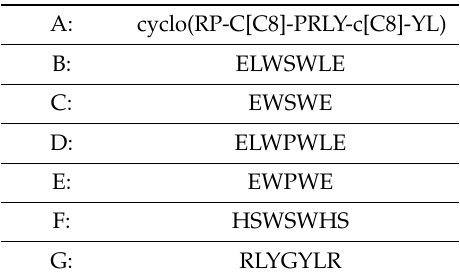
Table 1. Sequence structures of peptides used in this